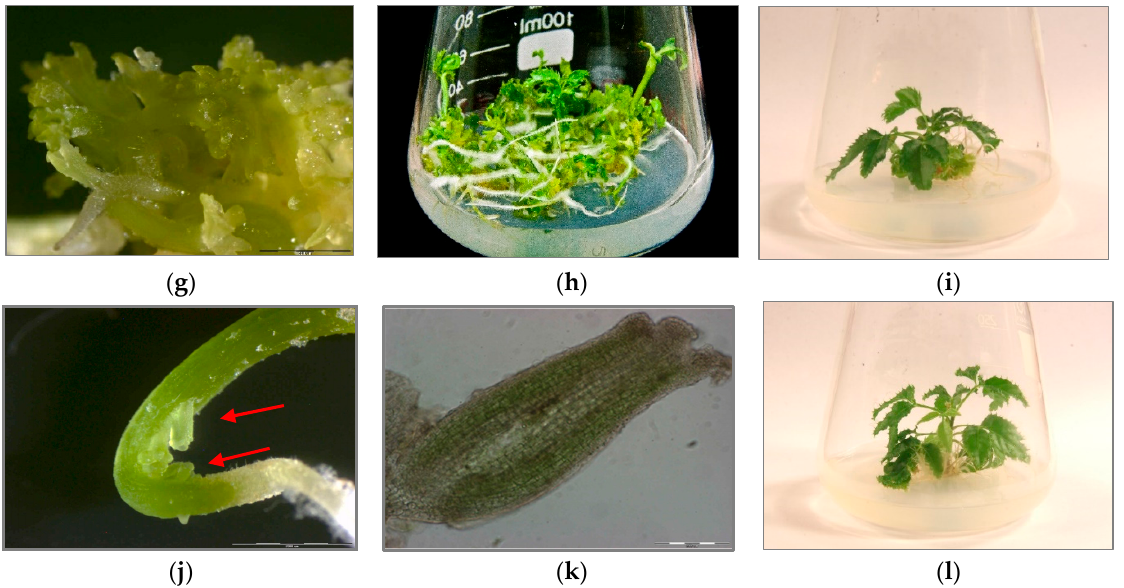
Figure 1. ( a ) Primary somatic embryos (PSE) of Polyscias filicifolia at different stages obtained after transferring embryogenic callus into hormone-free ½ Murashige and Skoog (MS) liquid medium within six-week passage (bar = 2000 µm). (b ) Conversion of PSE into plantlets after transfer on Nitsch and Nitsch medium (NN) solid medium supplemented with 0.5 mg/L kinetin (KIN), 0.1 mg/L indole-3-butyric acid (IBA) and 10 mg/L adenine sulfate (Ads). ( c ) Plantlets developed from germinating PSE after four-week culture. ( d ) Secondary somatic embryos (DSE) formed directly on the hypocotyl (H) of the PSE seven days after transferring onto hormone-free ½ MS solid medium and 15 g/L sucrose (cross-section) (bar = 200 µm). ( e ) DSE at different developmental stages: globular, heart-shaped, torpedo-shaped formed after three weeks of cultivation on hormone-free ½ MS solid medium and 15 g/L sucrose (bar = 2000 µm). ( f ) Cross-section of DSE in the torpedo stage formed on the hypocotyl part (H) of PSE after three weeks of culture on hormone-free ½ MS solid medium and 15 g/L sucrose (bar = 200 µm). ( g ) DSE germinating into plantlets after two weeks of culture on hormone-free ½ MS solid medium and 15 g/L sucrose (bar = 2000 µm). ( h ) Development of plantlets obtained from DSE after four weeks of culture on hormone-free ½ MS solid medium and 15 g/L sucrose. ( i ) Plantlet developed from DSE after four weeks of culture on NN solid medium supplemented with 0.5 mg/L KIN, 0.1 mg/L IBA and 10 mg/L Ads. ( j ) Development of TSE embryos directly on the hypocotyls of DSE two weeks after transfer to hormone-free ½ MS solid medium and 15 g/L sucrose (bar = 2000 µm). (k ) Cross-section of a TSE embryo in the early cotyledonous stage obtained on hypocotyl of DSE after three weeks of culture on hormone-free ½ MS solid medium and 15 g/L sucrose (bar = 200 µm). ( l ) Plantlet regenerated from TSE after four weeks of culture on NN solid medium supplemented with 0.5 mg/L KIN, 0.1 mg/L IBA and 10 mg/L Ads. Table 1. Summary of morphological features of three groups of Polyscias filicifolia regenerants obtained by indirect and direct somatic embryogenesis. Set of